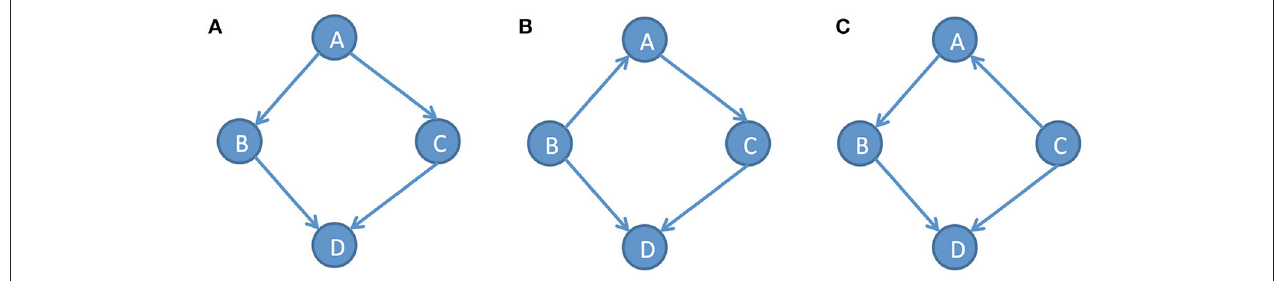
FIGURE 2 | Different DAGs can have same set of conditional independence distributions. (A) DAG example A, (B) DAG example B, (C) DAG example C.